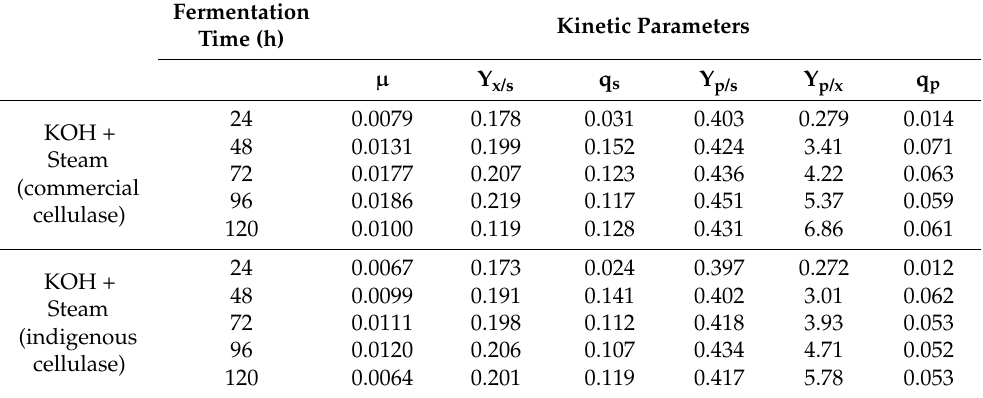
Table 4. Kinetic parameter estimation for ethanol fermentation in simultaneous saccharification and fermentation (SSF).